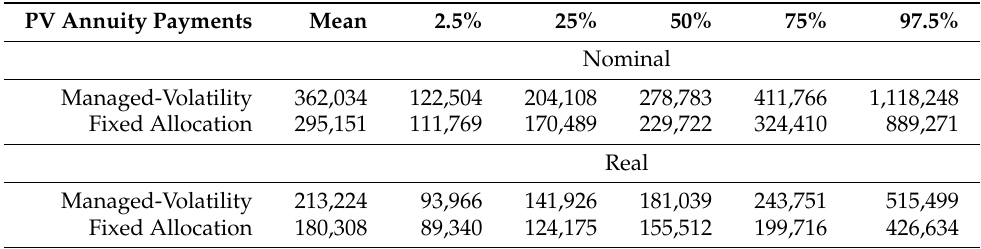
Table 4. Base Case: PV Annuity Payments—Nominal vs. Real.